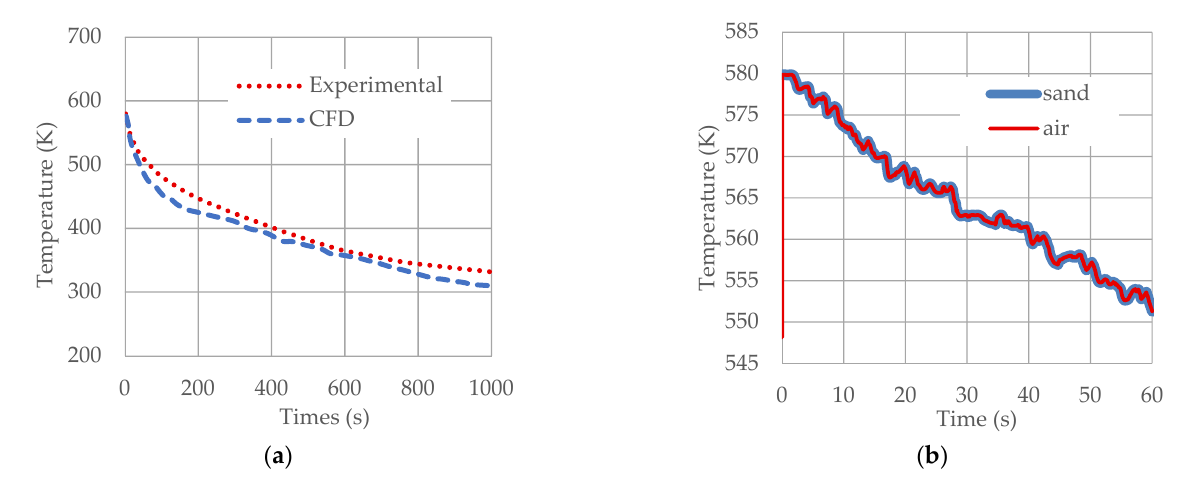
Figure 8. ( a ) The variations in air temperature in experimental and numerical studies at y = 0.10 m with u = 0.46 m/s; ( b ) the temperature variations of two phases at the first 60 s in CFD result in y = 0.10 m with u = 0.38 m/s.